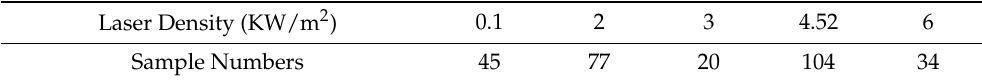
Table 1. Laser density in LC